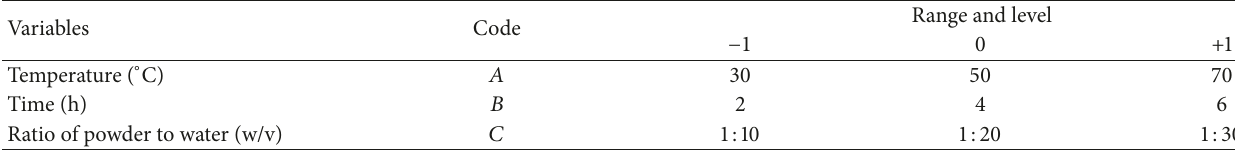
Table 1: Extraction factors and their levels for Box–Behnken